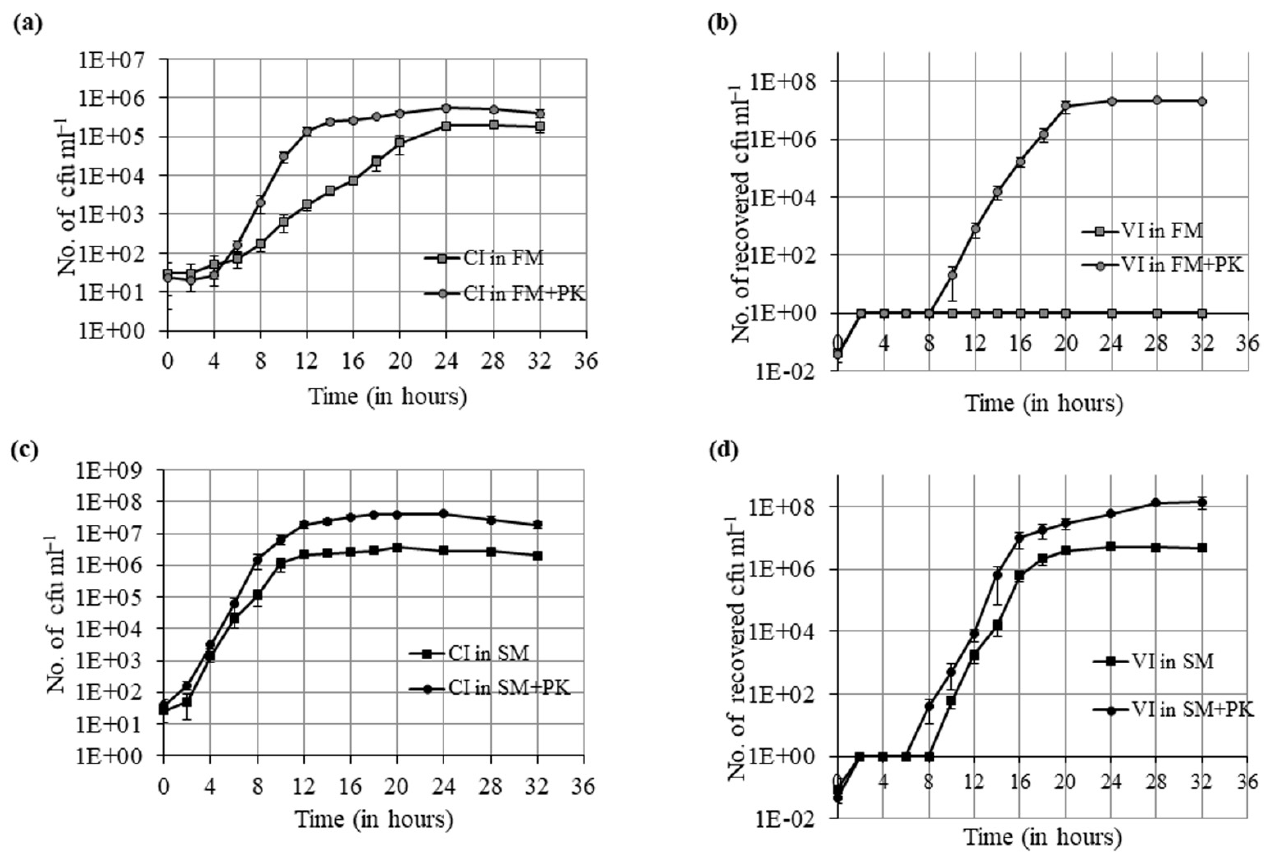
Figure 3. Time-dependent growth curve of culturable cells and resuscitation curve of VBNC cells in ASW (FM), ASW with proteinase K ( FM+PK), spent ASW (SM) and spent ASW with proteinase K (SM + PK). ( a ) Growth curve of cul- turable cells (CI cells) in FM ( ■ ) and FM+PK ( ● ) for 32 h at 37 ° C. The viable cell count was determined by the plate count method at an interval of 2 h until the end of incubation time. ( b ) Resuscitation curve of VBNC cells (VI cells) in FM ( ■ ) and FM+PK ( ● ) for 32 h at 37 ° C. ( c ) Growth curve of CI cells in SM ( ■ ) and SM+PK ( ● ) for 32 h at 37 ° C.( d ) Resuscitation curve of VI cells in SM ( ■ ) and SM+PK ( ● ) for 32 h at 37 ° C. Each data point represents the mean ± SE of three independent ex- periments.